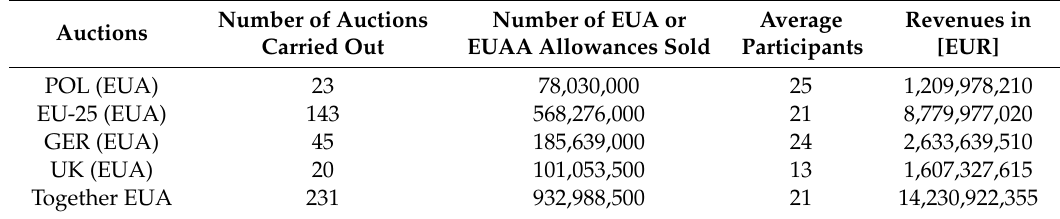
Table 3. Summary of the EUA auction held in